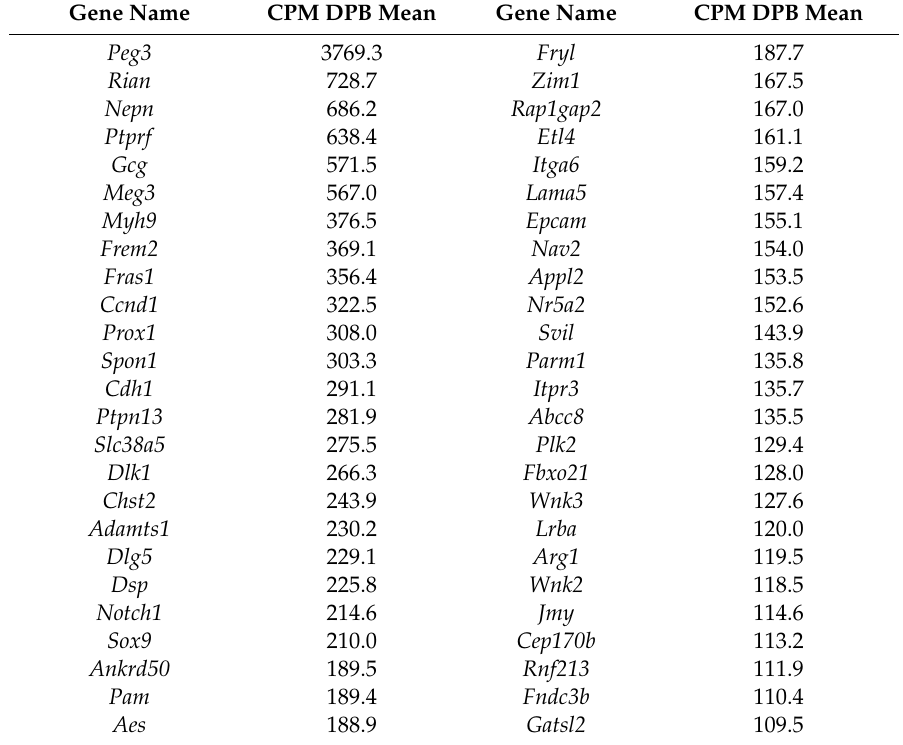
Table 1. List of the enriched DPB genes in mouse embryo at E10.5.